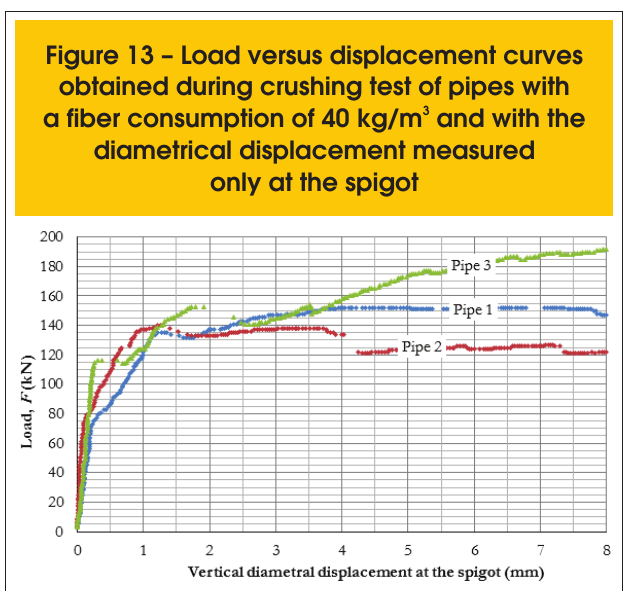
Figure 14 – Load versus displacement curves obtained during crushing test of pipes with conventional reinforcement and with the diametrical displacement measured only at the spigot